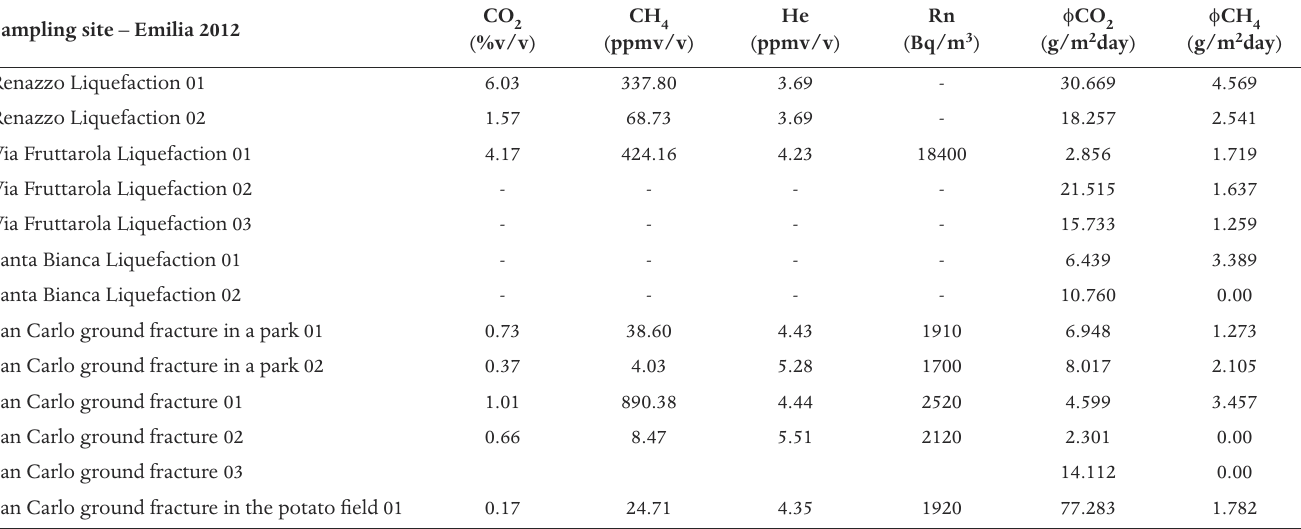
Table 1. Measurements of fluxes and soil-gas concentrations for liquefactions and ground fractures in the Finale Emilia (Modena) area (Via Fruttarola and Santa Bianca), and in the Ferrara area (Renazzo and San Carlo), during 2012 earthquake sequence.